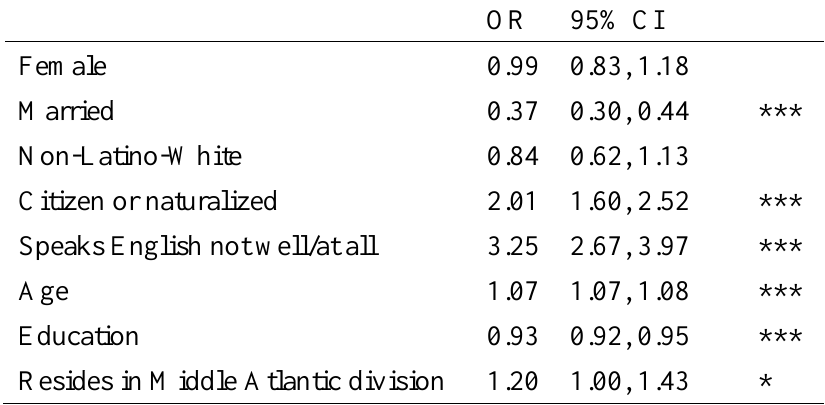
Table 2. Multivariable logistic regression predicting the likelihood of being